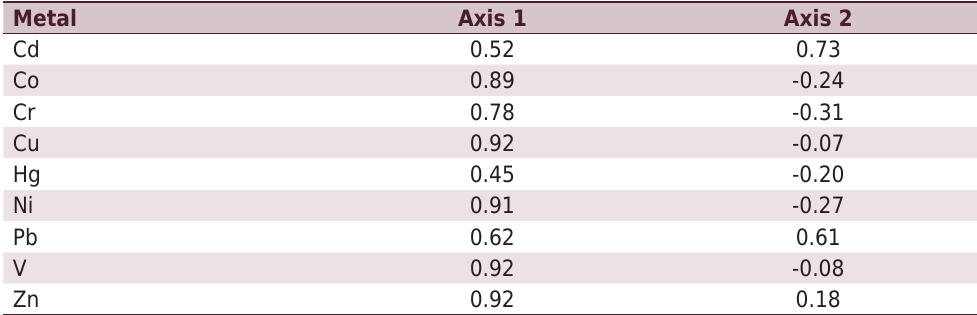
Table 4. Correlation coefficients obtained by principal component analysis relating metals to